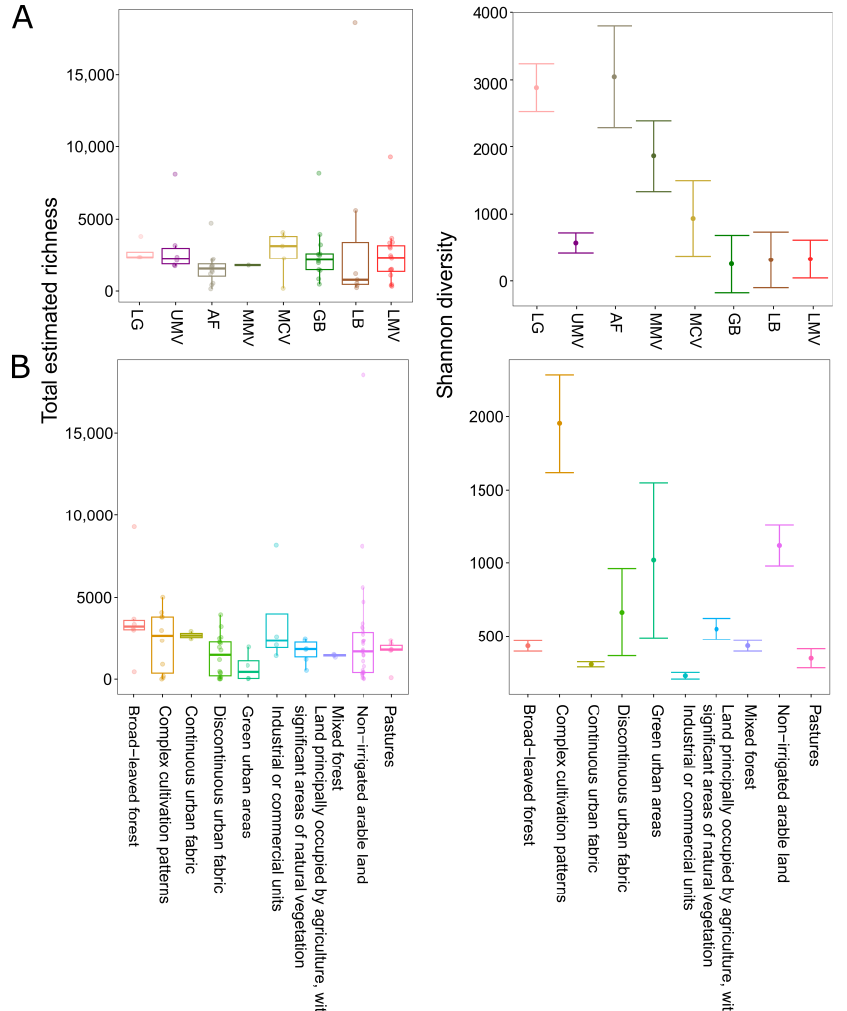
Figure 7. ( A ) Diversity metrics of groundwater prokaryotic communities between regions and ( B ) related to different land use types. Total estimated richness is depicted in form of boxplots showing median values as midline, first, and third quantiles as edges, and whiskers representing the max/min values. Shannon diversities are shown as effective species numbers with error bars showing the mean estimates from covariate-wise estimations ± SE.